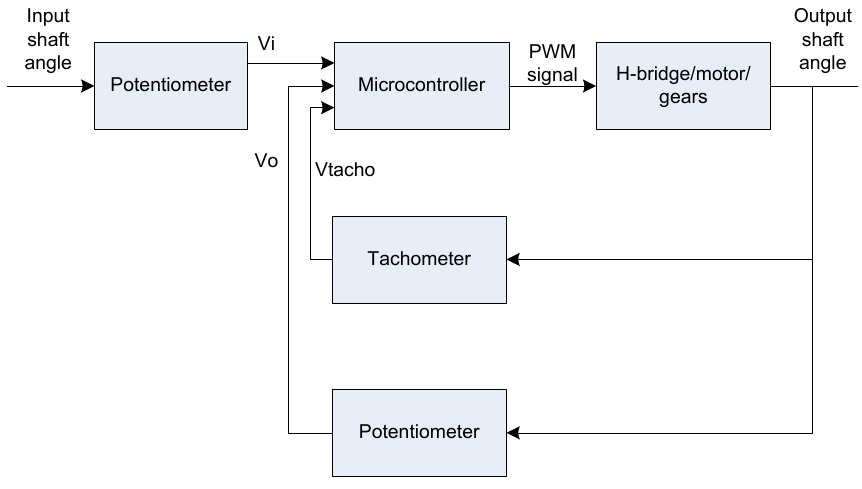
Fig. 9. Position control system with microcontroller-based velocity feedback